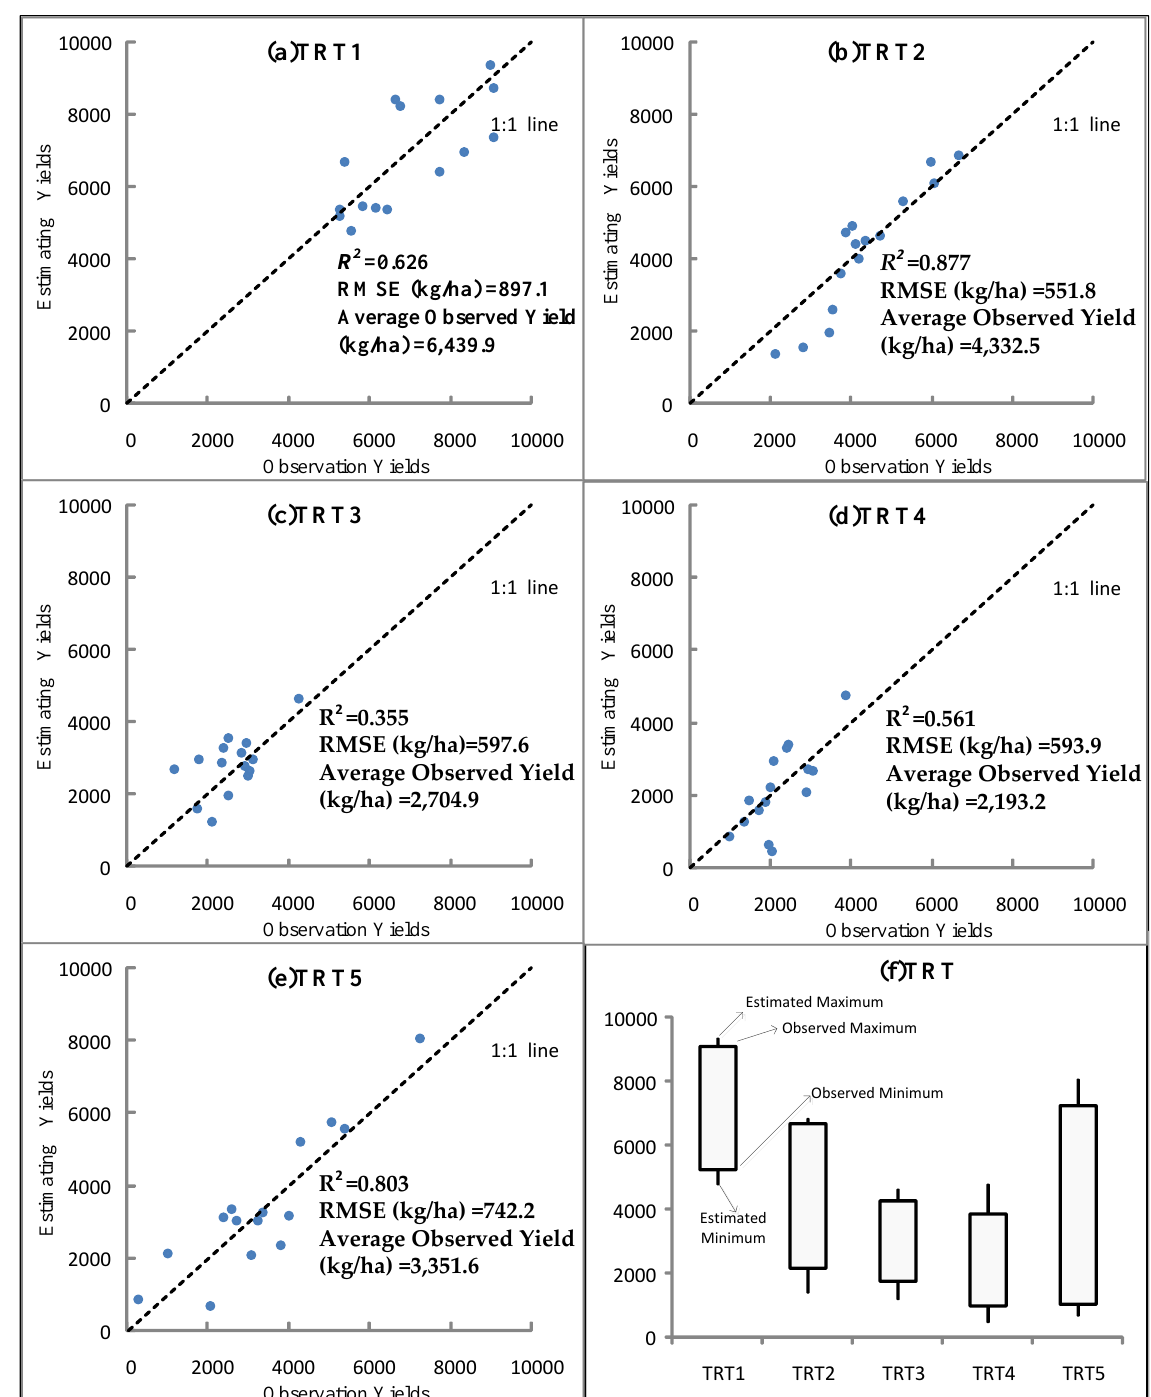
Figure 7. Comparison between SAFY model estimated and in situ measurement of grain yield for five irrigation scenarios ( a – e ). The maximum/minimum of observed yield and the maximum/minimum of estimated yield ( f ).